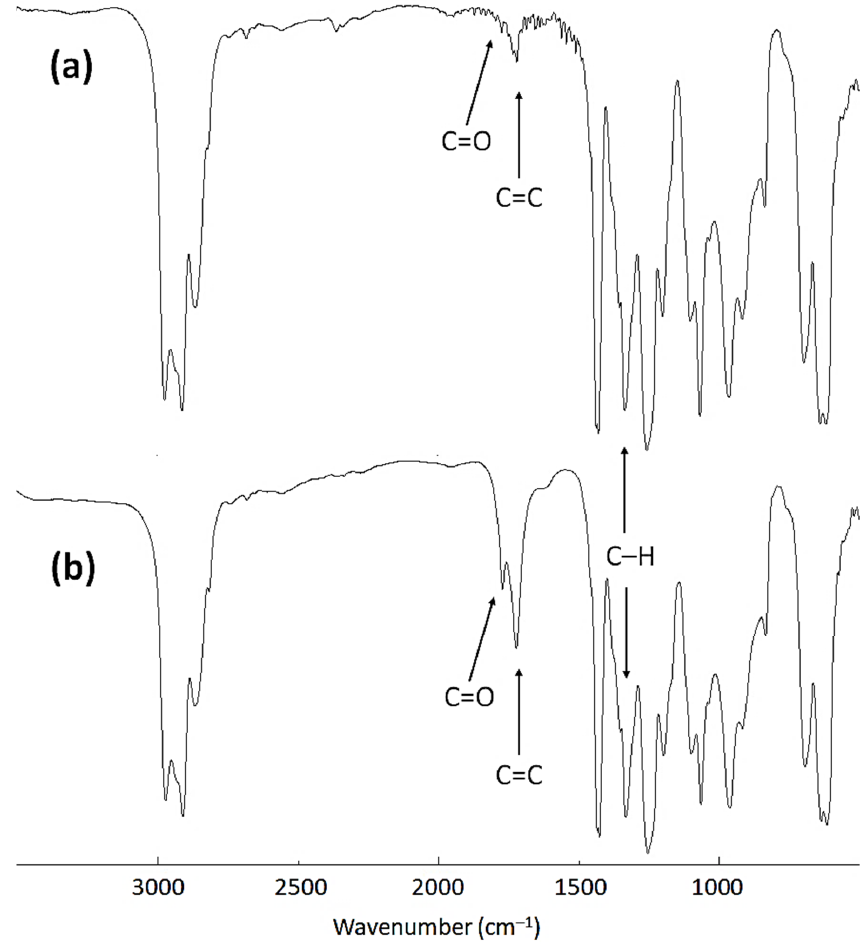
Figure 1. FTIR spectra of the pure PVC film pre ‐ and post ‐ irradiation. Equation (1) has been used to calculate the indices of both C=O ( I C=O ) and C=C ( I C=C ) groups for the pure PVC film and the blends containing 1–3 after every 50 h of irradiation. The changes in I C=O and I C=C for the PVC during irradiation are shown in Figures 2 and 3, respectively. It was clear that the changes in the I C=O and I C=C were significantly higher and sharper in the case of the pure PVC film. Complexes 1–3 evidently reduced the formation of small fragments containing C=O and C=C groups and hence acted as PVC photostabilizers. For the pure PVC film, the I C=C was 0.53 after 50 h, 0.80 after 100 h, 1.01 after 200 h, and 1.51 after 300 h of irradiation. The PVC film containing 1 showed the lowest I C=O at 0.26 after 50 h, 0.40 after 100 h, 0.58 after 200 h, and 0.71 after 300 h of irradiation. The superior